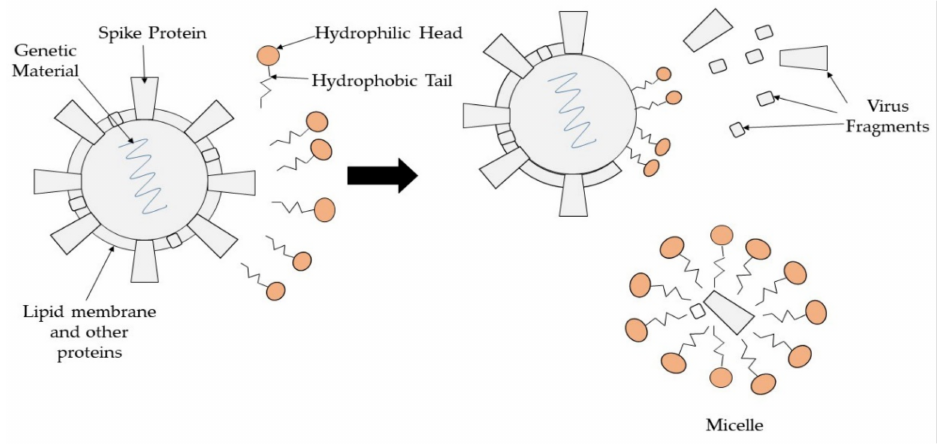
Figure 5. Mechanism of surfactants for inactivating